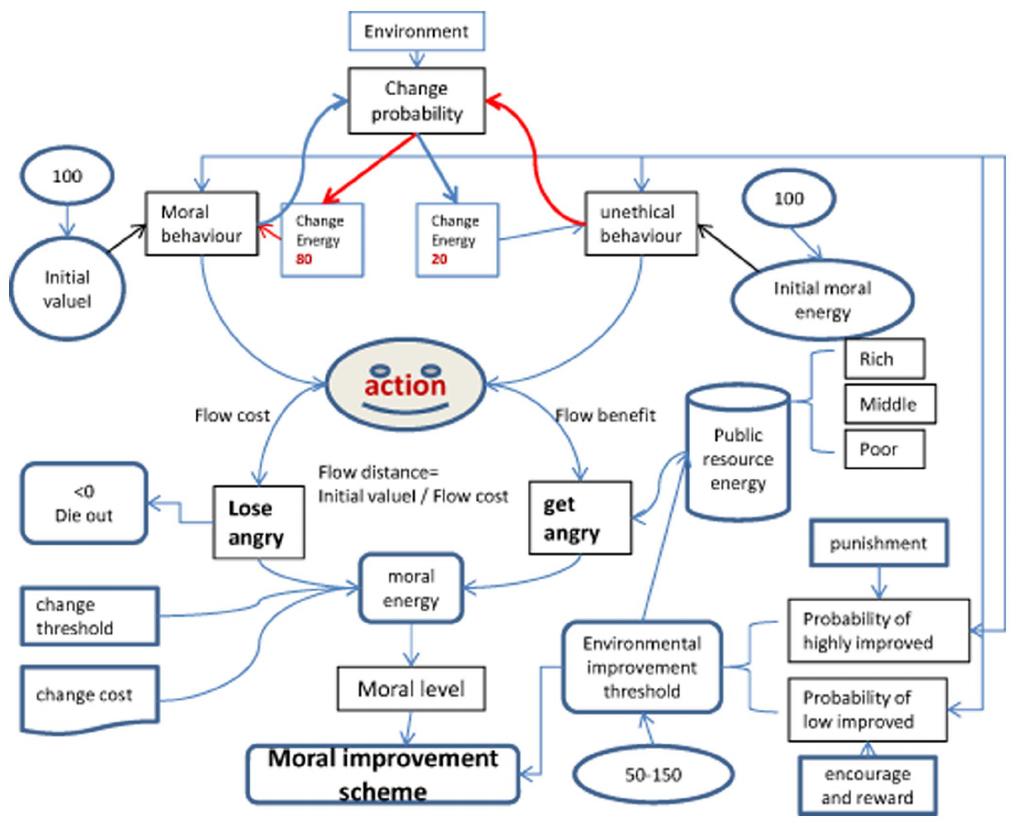
Figure 1. Moral computing simulation flowchart. This figure shows the basic principle of social moral level by quantitative analysis. As a starting point, we divide social agents into moral and immoral actors, and given their initial energy value. They move to gain or lose energy in the social environment. Public resources, agent energy value accord to set rules for interaction. Finally, we can get the level of social morality.